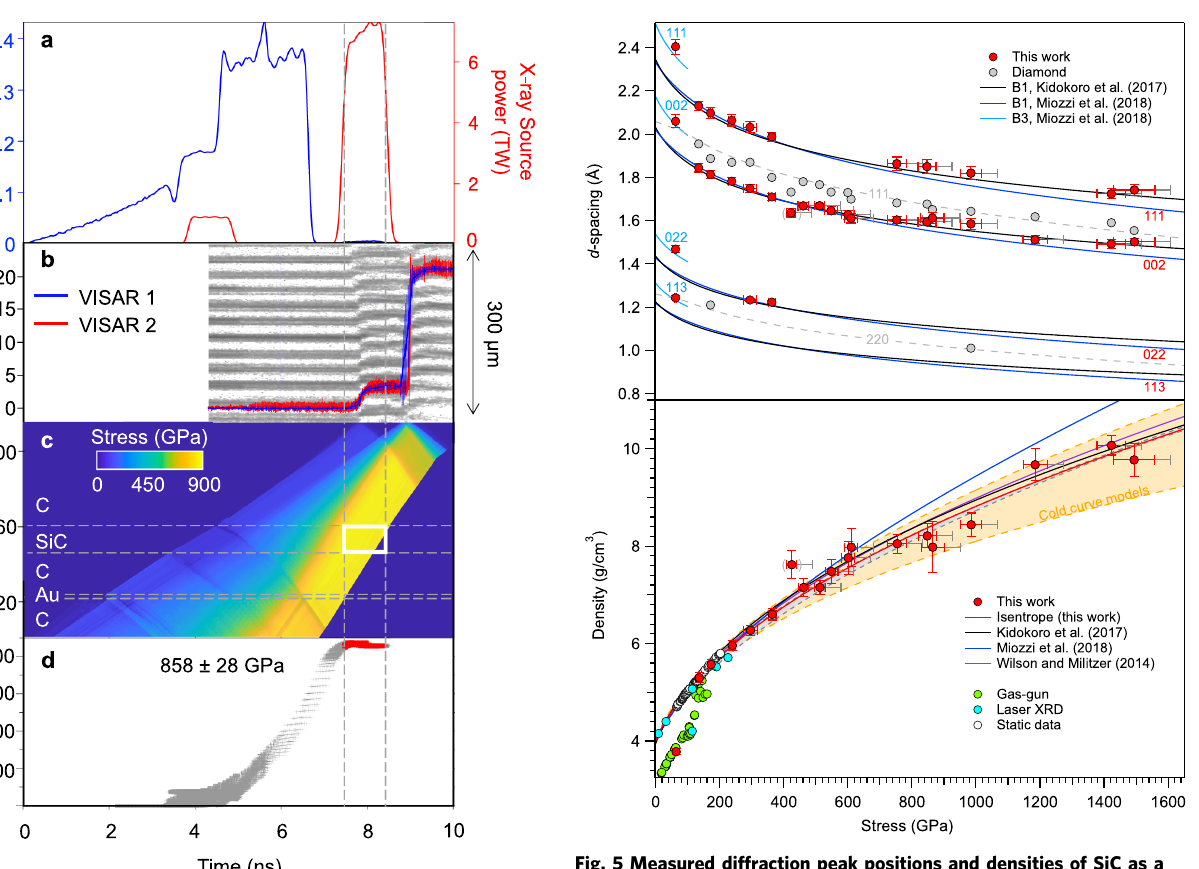
core (30% by mass). Figure 7 shows the mass-radius relationship for such planets extending up to 10 Earth masses in size. The red and gray regions in the fi gure represent the range of mass-radius curves depending on the core composition. Our result shows that SiC is less dense than MgSiO 3 50 and hence a planet with a SiC (red region) or C and SiC (gray region) mantle would be lighter